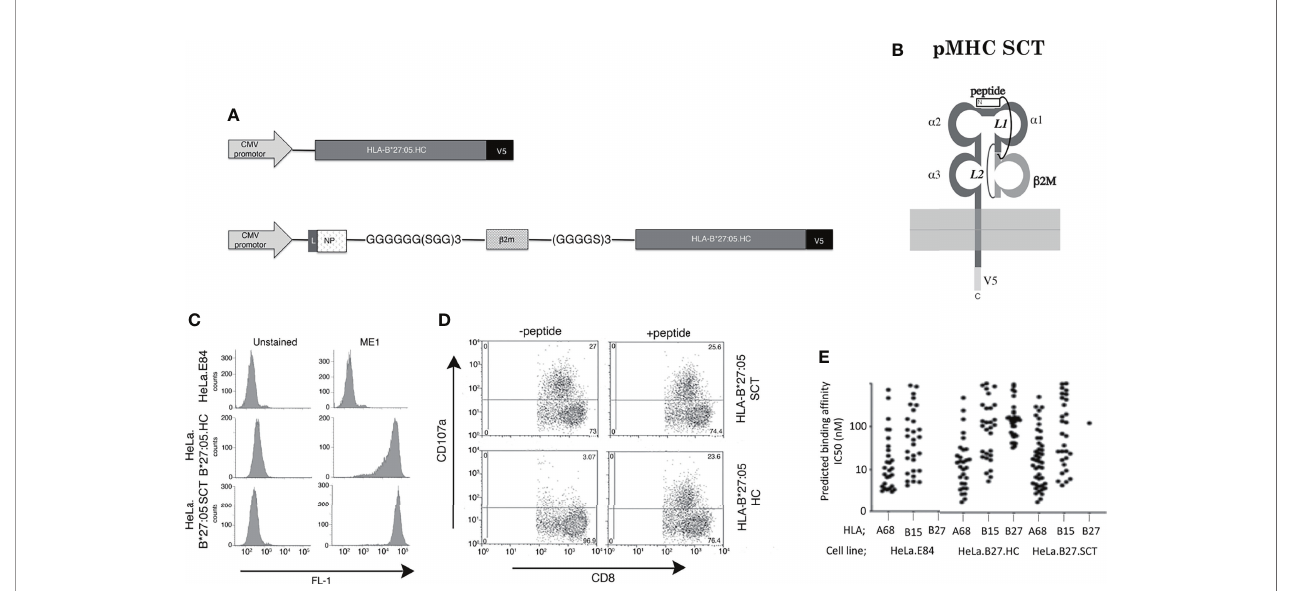
FIGURE 1 | Construction and T cell recognition of HLA class I single chain trimeric (SCT) molecules; (A) Schematic outlining the HLA-B*27:05.heavy chain (HC) and HLA-B*27:05.SCT construct composed of hu b 2m leader sequence (L)-SRYWAIRTR (NP) peptide-GGGGGG(SGG) 3 linker-hu b 2m-(GGGGS) 3 linker-B27 heavy chain and V5 epitope tag. (B) Diagram of the HLA-B27.SCT. molecule composed of an N-terminal peptide linked to the N-terminus of b 2m by linker 1 (L1). B2m is linked to the a 1 domain of the MHC class I HC via linker 2 (L2) and the MHC class I HC was tagged (V5) at the C-terminus. (C) Cell surface expression of HLA-B*27:05 heavy chain and SCT formats expressed using the FLPIN system under the control of the HCMV promoter as determined by ME1 staining. (D) In fl uenza speci fi c HLA-B*27:05 restricted CTL lines can ef fi ciently be activated by HLA-B*27:05.SCT as well as HLA-B*27:05.HC lines pulsed with NP speci fi c peptide. (E) Peptides were eluted and analysed by mass spectrometry and HLA class I binding af fi nity prediction from W6/32 immunoprecipitations of the cell lines. A signi fi cant number of HLA-B*27:05 binding peptides was detected only in the HLA-B*27:05.HC cell line, with only a single peptide detected in HLA.B*27:05.SCT and none in control HeLa.E84